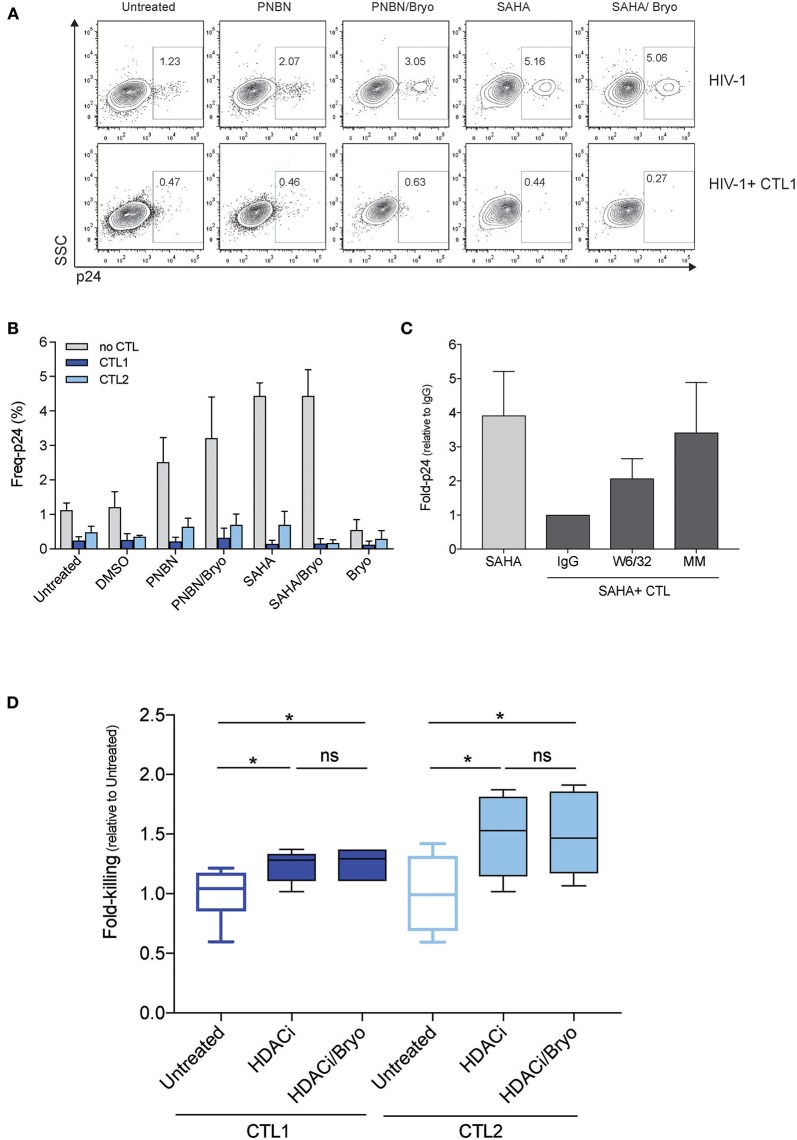
LRA treatment increased the magnitude of killing of HIV-1 reactivated cells by CD8+ T cells. (A) Representative dot plots showing the frequency of p24 cells from live HIV-1 reactivated cells in the absence (top) or in the presence of CTL1 for 20 h. (B) Frequency of p24 cells from HIV-1 reactivated cells inthe absence or presence of CTLs (CTL1 and CTL2). The graph represents the mean ± SEM of three independent experiments performed in duplicate. (C) Fold-p24 expression relative to SAHA-reactivated cells in the presence of HLA-matched CTLs treated with isotype control antibody IgG. SAHA-reactivated cells in the absence or presence of HLA-matched CTLs (CTL1, CTL2), treated isotype control antibody IgG (IgG), and HLA-blocking antibody (W6/32), and in the presence of HLA-mismatched CTL3 (MM). The graph represents the mean ± SD of three experiments performed in duplicate. (D) Relative killing of RELI cells by untreated CTL1 and CTL2 and presence of HDACi (including PNBN and SAHA) alone and combined with Bryo. Box and whisker plots included data from four independent experiments performed in duplicate. The p-values were calculated using the Mann-Whitney test. Only significant values are shown in the figure (*p < 0.05).